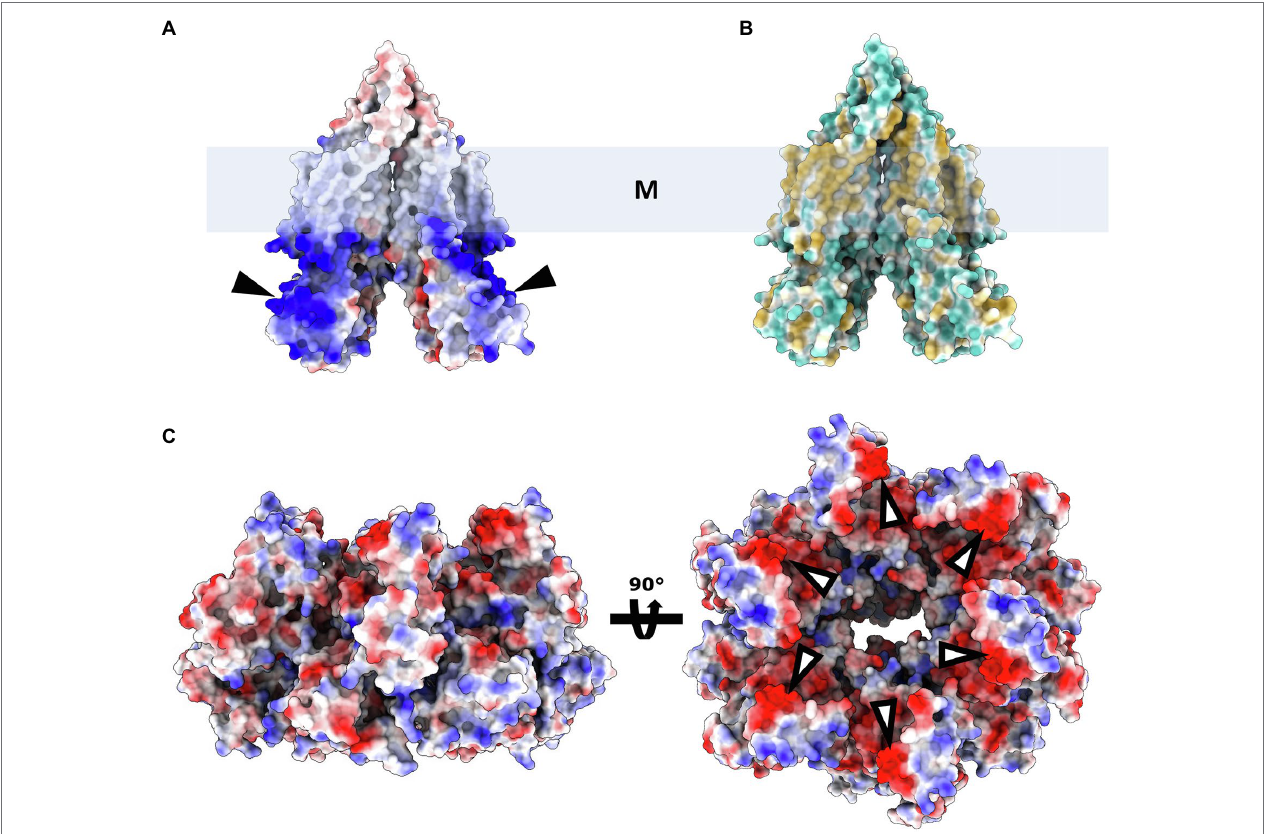
FIGURE 4 | ArlJ modelled as a dimer. (A) , surface representation of electrostatic potential (red, negative; white, neutral; and blue, positive local charges). (B) , surface representation of ArlJ coloured by hydrophobicity (blue, hydrophilic; yellow, hydrophobic). The position of the membrane (represented by the box M) can be inferred from the location of the hydrophobic belt (B) . According to the positive-inside rule, the positively charged domains (A) are likely located in the cytoplasm. (C) , ArlI (PDB-4IHQ) surface representation coloured by electrostatic potential. The complementary local charges in ArlJ and ArlI (black and white arrows, respectively) hint at electrostatic interactions between both proteins.